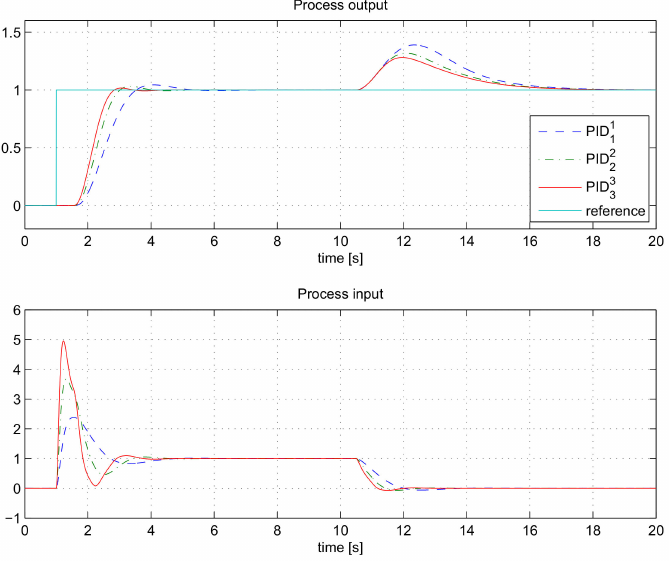
Figure 4. The closed-loop responses for the process G P 2 ( s ) when using controllers PID 1 and PID 3 3